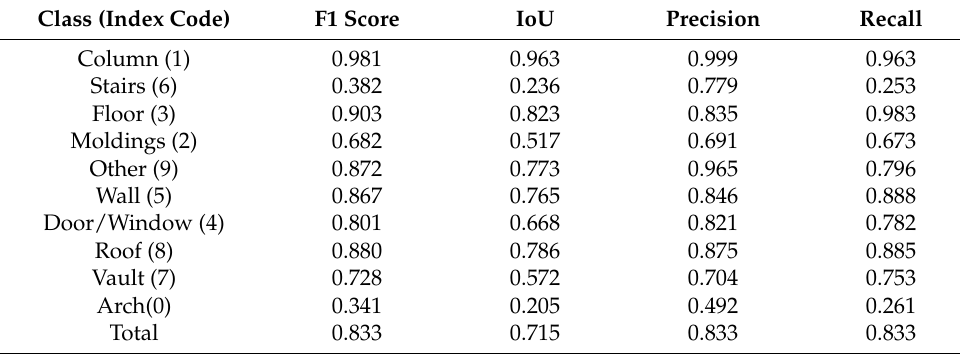
Table 1. Metric results of the object recognition for the Sacro Monte first